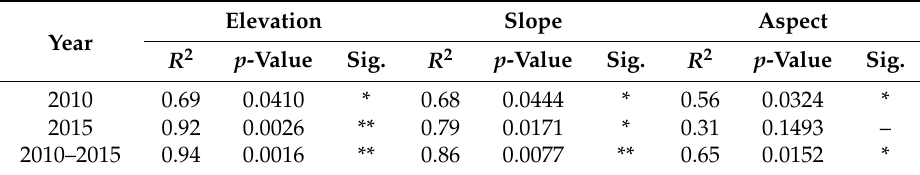
Figure 8. AGB/change within the stratified topography in Xianju County: ( a ) AGB/change with elevation; ( b ) AGB/change with slope; ( c ) AGB/change with aspect; ( d ) radar chart of AGB/change with aspect. Table 5. Regression results between AGB/change and terrain features in Xianju County.